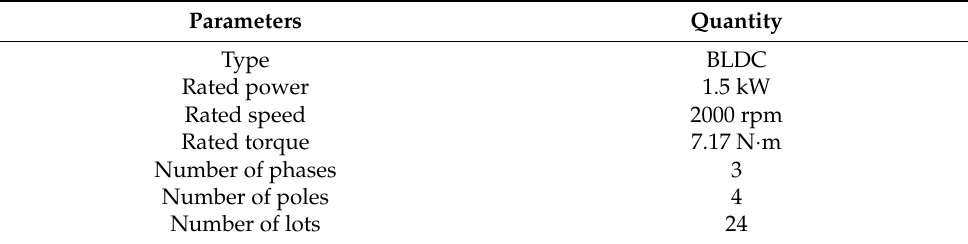
Table 1. Parameters of BLDC